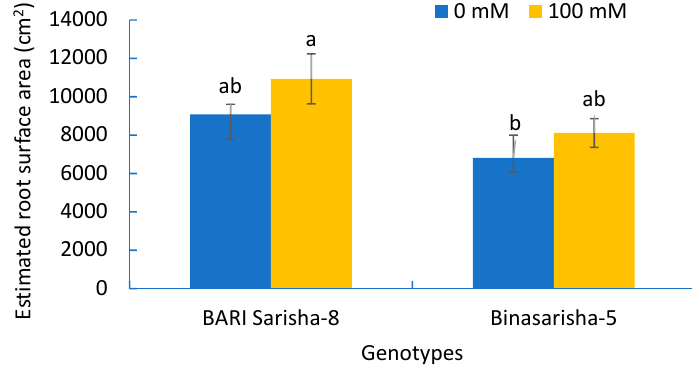
Figure 7. Estimated root surface area of two rapeseed varieties under 0 mM and 100 mM NaCl treatments. Vertical bars indicate standard error of mean of four replicates against each variable. Different letters indicate significant differences among the genotype × treatment interactions. Plants 2019 , 8 , x FOR PEER REVIEW